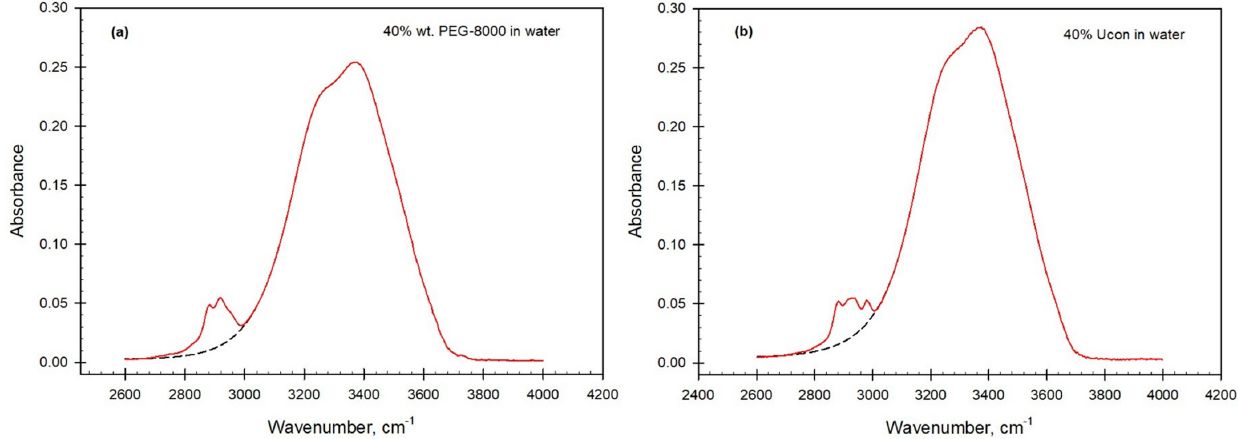
Figure 1. ATR − FTIR spectra of the OH-stretch band observed (solid red) and interpolated (dashed black) in 40% wt. aqueous solutions of ( a ) PEG-8000 and ( b ) Ucon-3230.